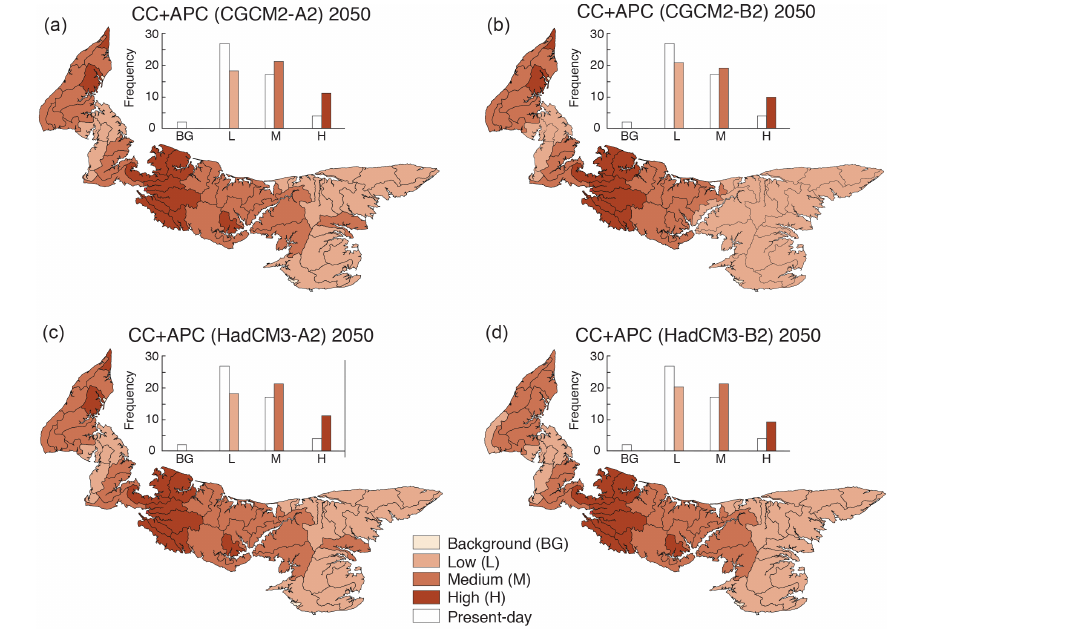
Figure 8. Class distribution of simulated mean nitrate concentration per watershed and histogram of the number of watersheds in each class for the four climate change (CC) scenarios with ensuing agricultural practice adaptation (APC) ( a , b , c and d